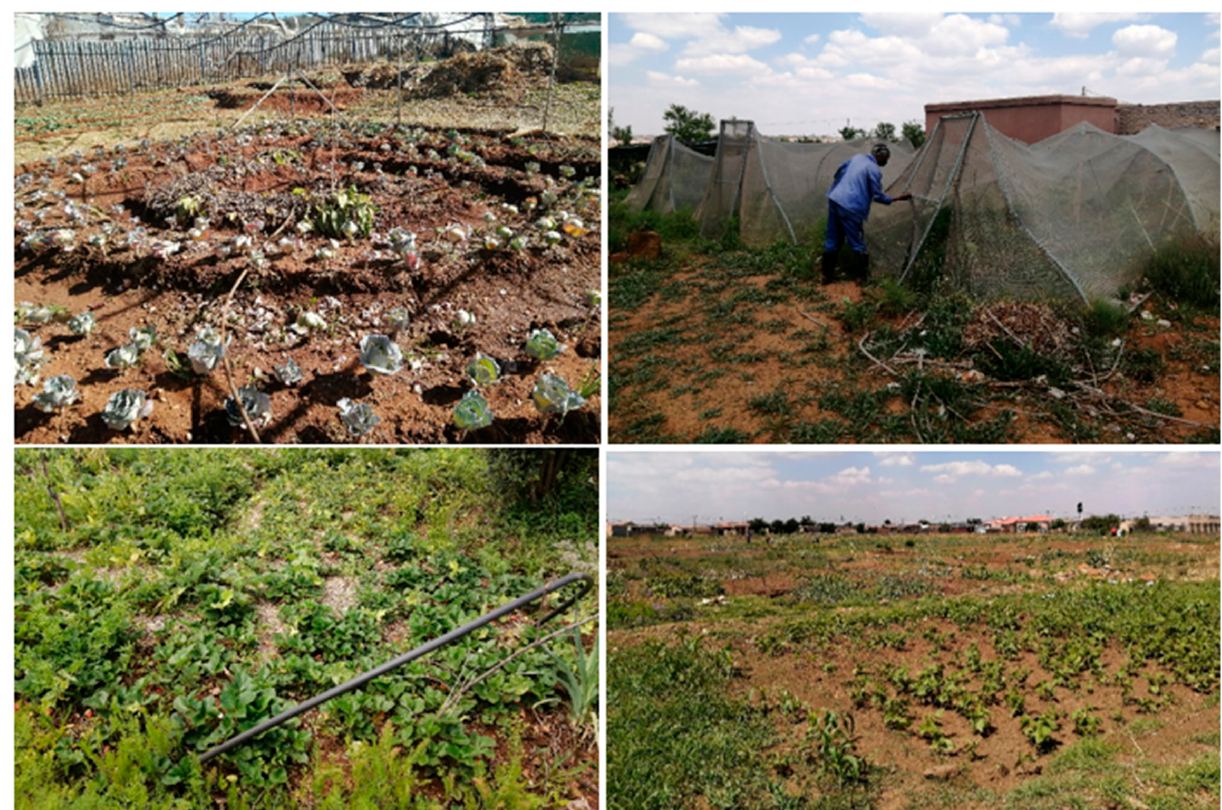
Figure 4. Existing urban agricultural activities in marginally suitable and suitable areas.